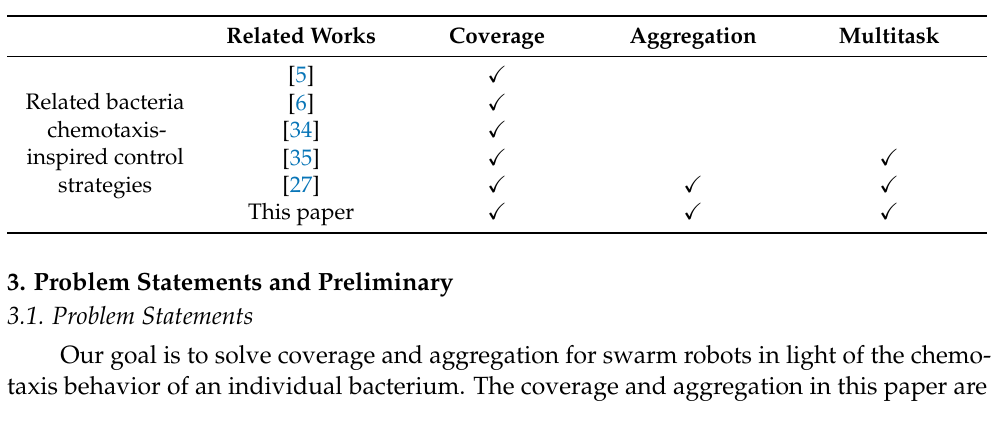
Table 1. The summary of related